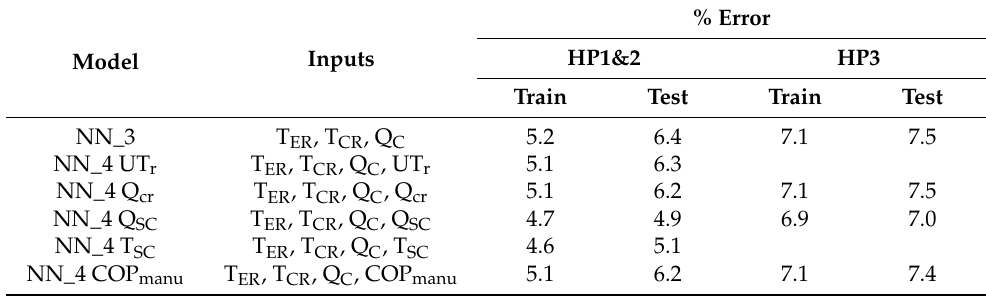
Table 6. Step 1 of forward selection.